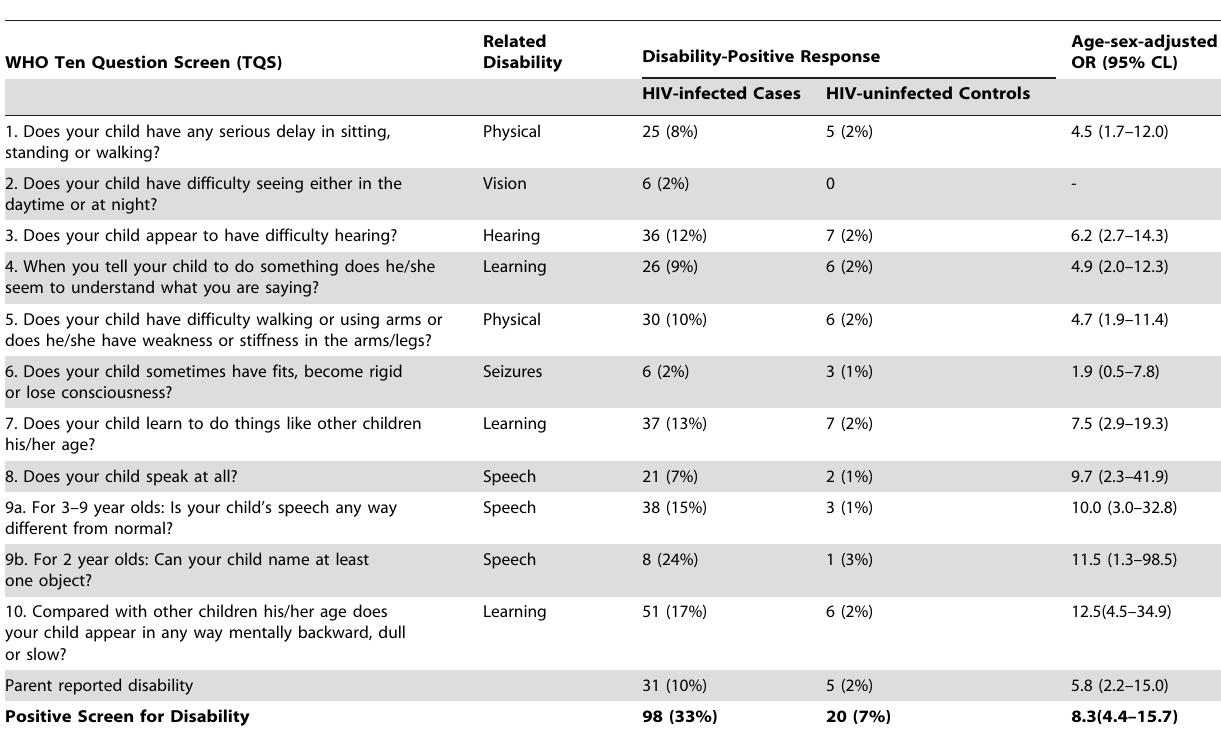
Table 2. Reported disability by WHO Ten Question Screen in HIV-infected cases and HIV-uninfected controls.